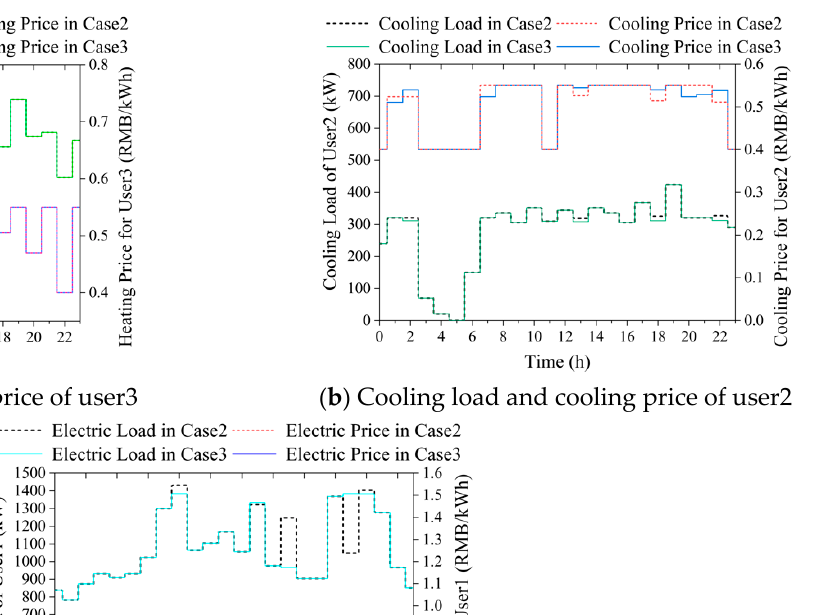
Figure 9. Strategies comparison between case2 and case3 in summer.